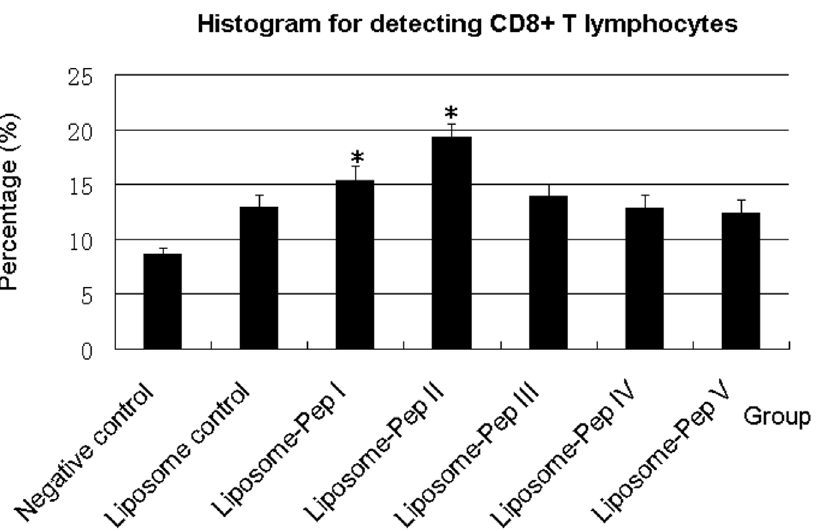
Figure 2. Detection of CD8 + T lymphocytes. Detection of CD8 + T lymphocytes was done after booster immunization at 11 weeks. Negative control showing only 8.7% CD8 + T lymphocytes in total karyoctes. Liposome control showing 12.9% CD8 + T lymphocytes. Peptide I showing 15.4% CD8 + T lymphocytes. Peptide II with 19.3% CD8 + T lymphocytes. Peptide III with 13.9% CD8 + T lymphocytes. Peptide IV with 12.8% CD8 + T lymphocytes. Peptide V with 12.4% CD8 + T lymphocytes. CD8 + T cell proliferation in cells stimulated with peptide I and peptide II was significantly higher than that in cells stimulated with liposomes ( P , 0.05). Cumulative average ( n =5) per group for the groups described in Table 2. * P , 0.05 vs. Liposome control.